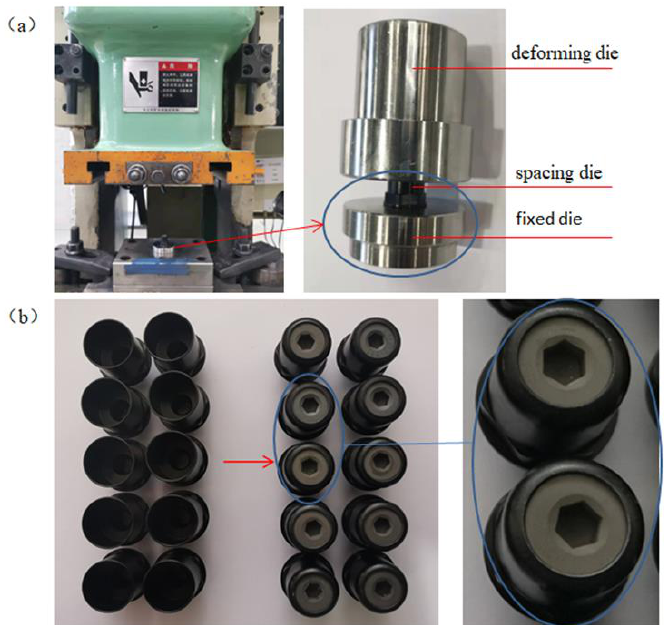
Figure 10. Process validation test: ( a ) equipment and die; ( b ) product photographs.